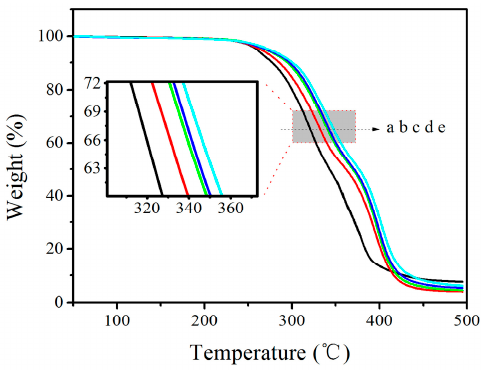
Figure 4. Thermogravimetric analysis (TGA) curves: LCPU ( a ); LCPU5 ( b ); LCPU10 ( c ); LCPU15 ( d ); LCPU20 ( e ).